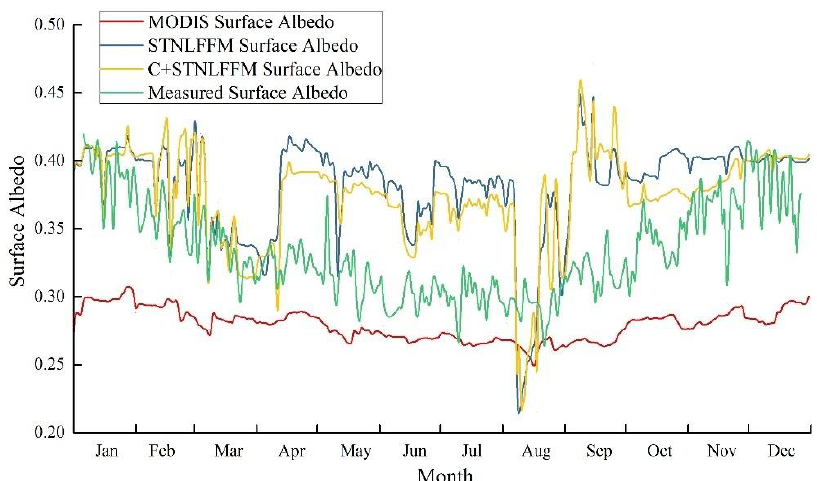
Figure 2. Surface albedo fusion results based on STNLFFM and C + STNLFFM at the Guaizi Lake meteorological station in 2016.